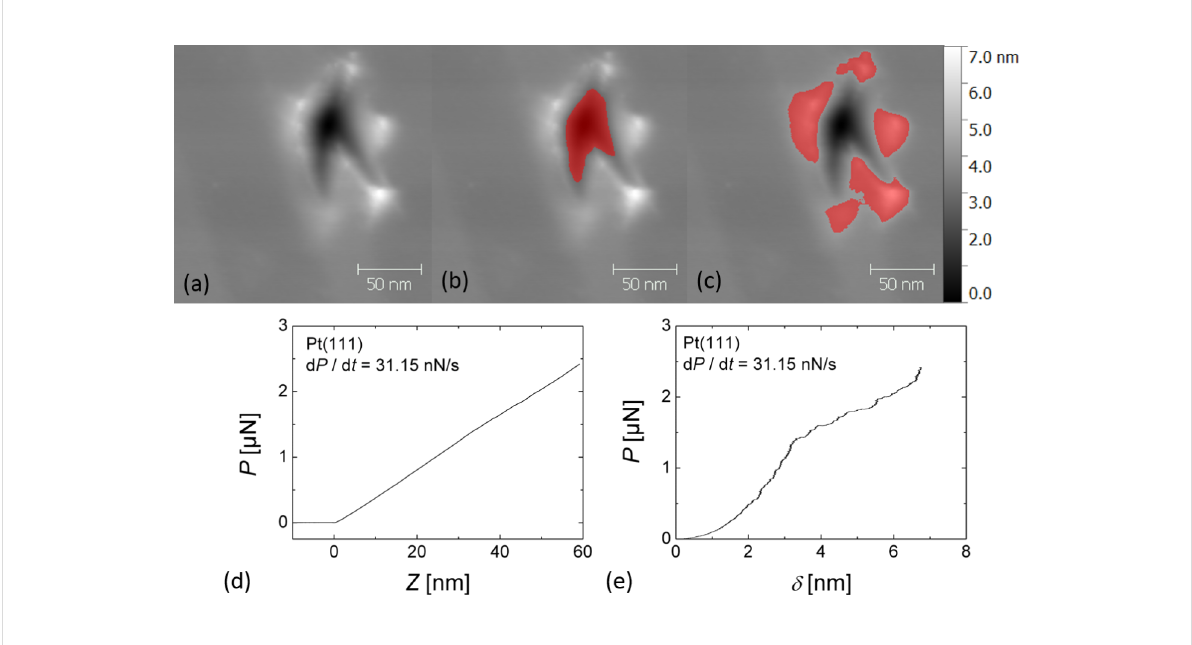
Figure 1: (a) Non-contact (nc)-AFM image of an AFM-indentation on Pt(111) ( z -scale: 7 nm) and highlighted masks used to determine (b) the projected area and (c) the pile-up volume of the AFM indentation shown in (a); in (a–c) the z -scale is 7 nm; (d) force distance–curve recorded on Pt(111) at the indicated loading rate and (e) corresponding AFM indentation curve. As described in the text, (e) is extracted from (d) by subtracting the deflection of the